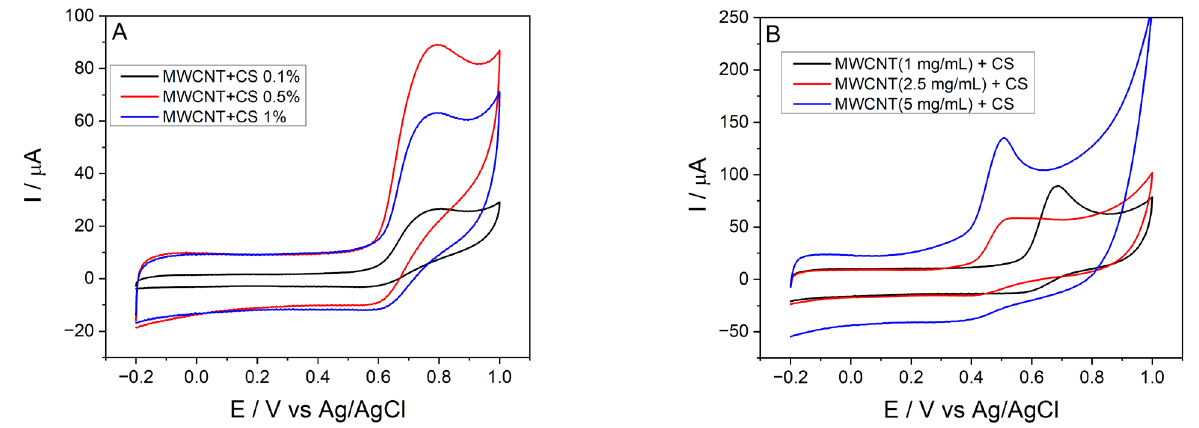
Figure 8. Cyclic voltammograms recorded with MWCNT-CS-based sensors: ( A ) MWCNT 1 mg/mL and CS (0.1;0.5 and 1%), and ( B ) MWCNT (1;2.5 and 5 mg/mL) and CS 0.5% (acetate buffer 0.1 M, pH 5.0, 1 mM nitrite, scan rate of 0.05